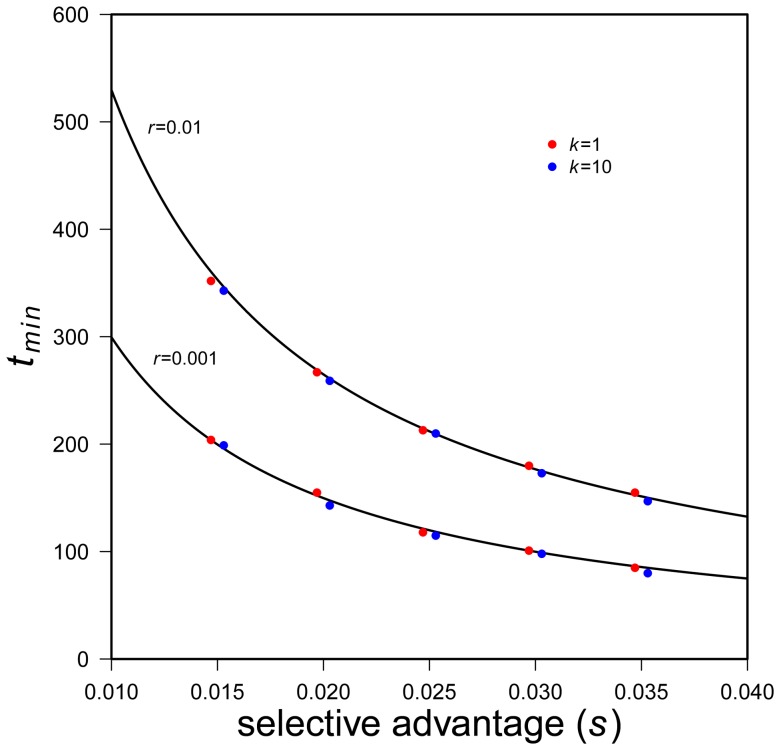
Time to minimum expected population size.Black lines are predicted tmin (Eq. 13), simulation results with k = 1 are red dots, simulation results with k = 10 are blue dots. Two values of r are used (see plot), N0 = 10,000. 5000 successful realizations for each set of parameters.